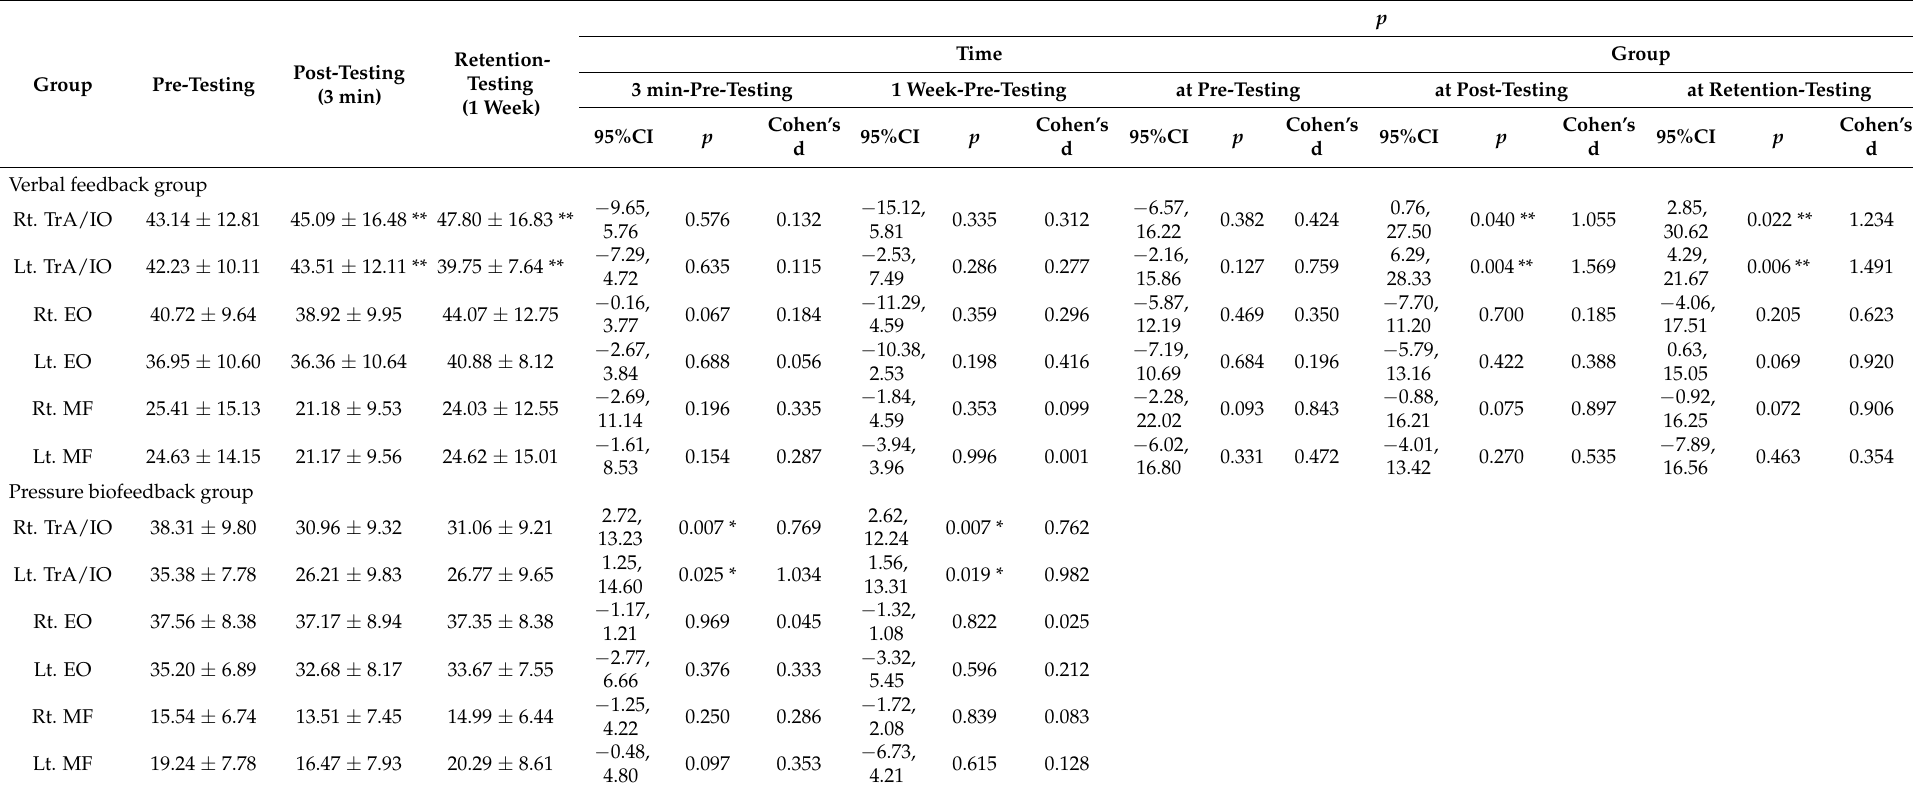
Table 2. Muscle activity (%MVIC) in response to